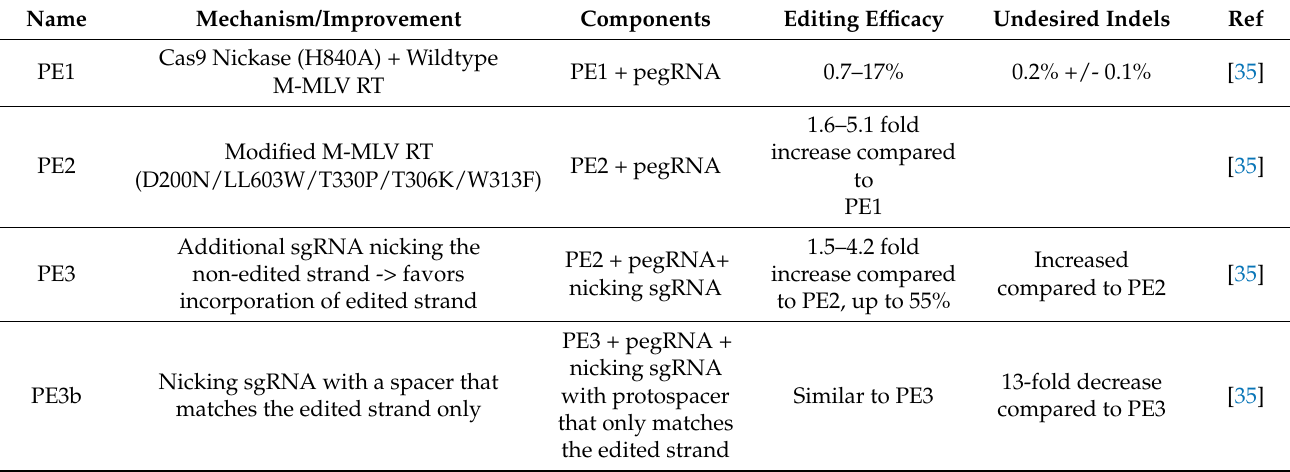
Table 1. Advances in the Prime editing